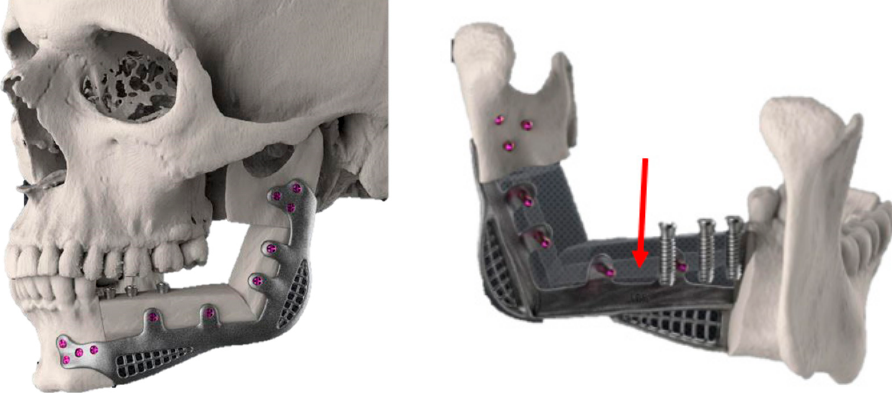
Figure 2. Titanium plate planning. The PSI features an accommodation for the placement of fibula segments (shown by red arrow). A grid is present for better integration with soft tissue.